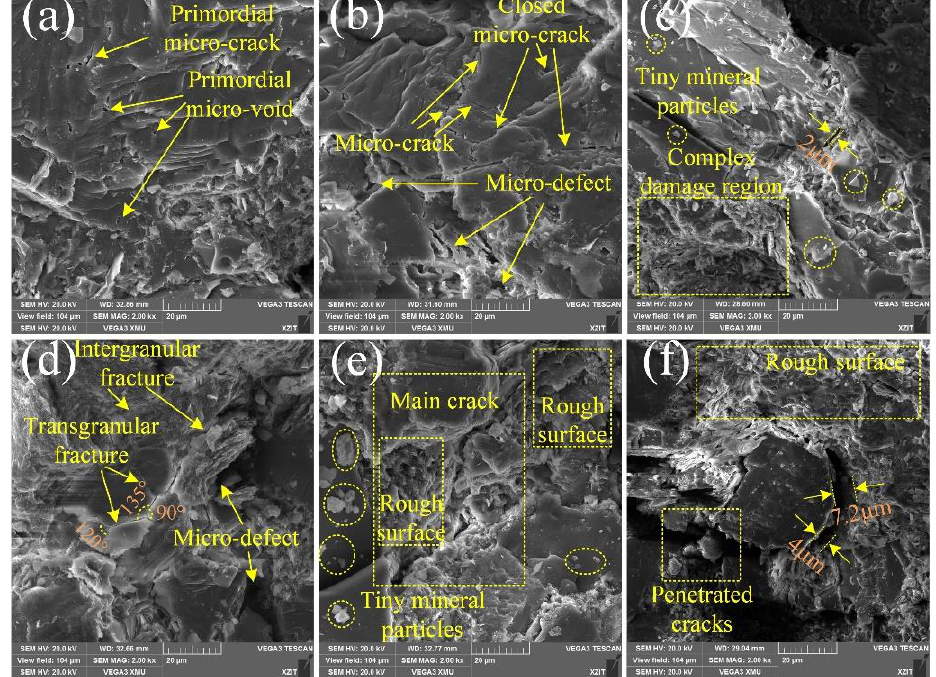
Figure 15. The SEM images of sandstone: ( a ) primordial sandstone; ( b ) sandstone with D A = 0.1080; ( c ) sandstone with D A = 0.5002; ( d ) primordial sandstone after impact loading; ( e ) sandstone with D A = 0.1080 after impact loading; and ( f ) sandstone with D A = 0.5002 after impact loading.